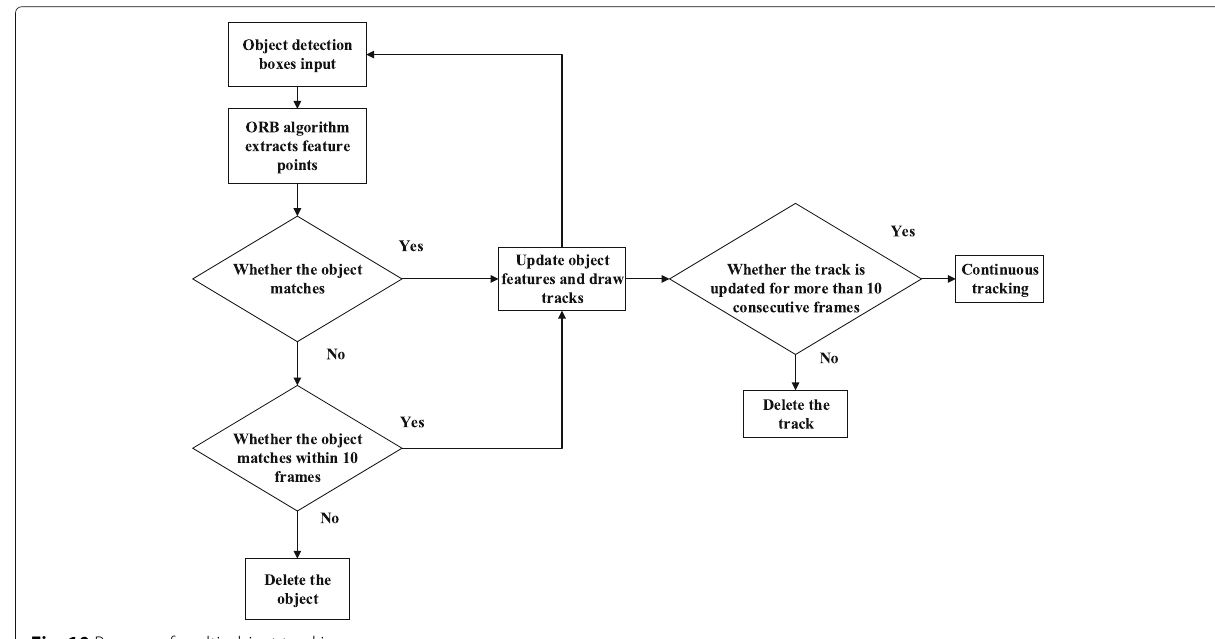
Fig. 10 Process of multi-object